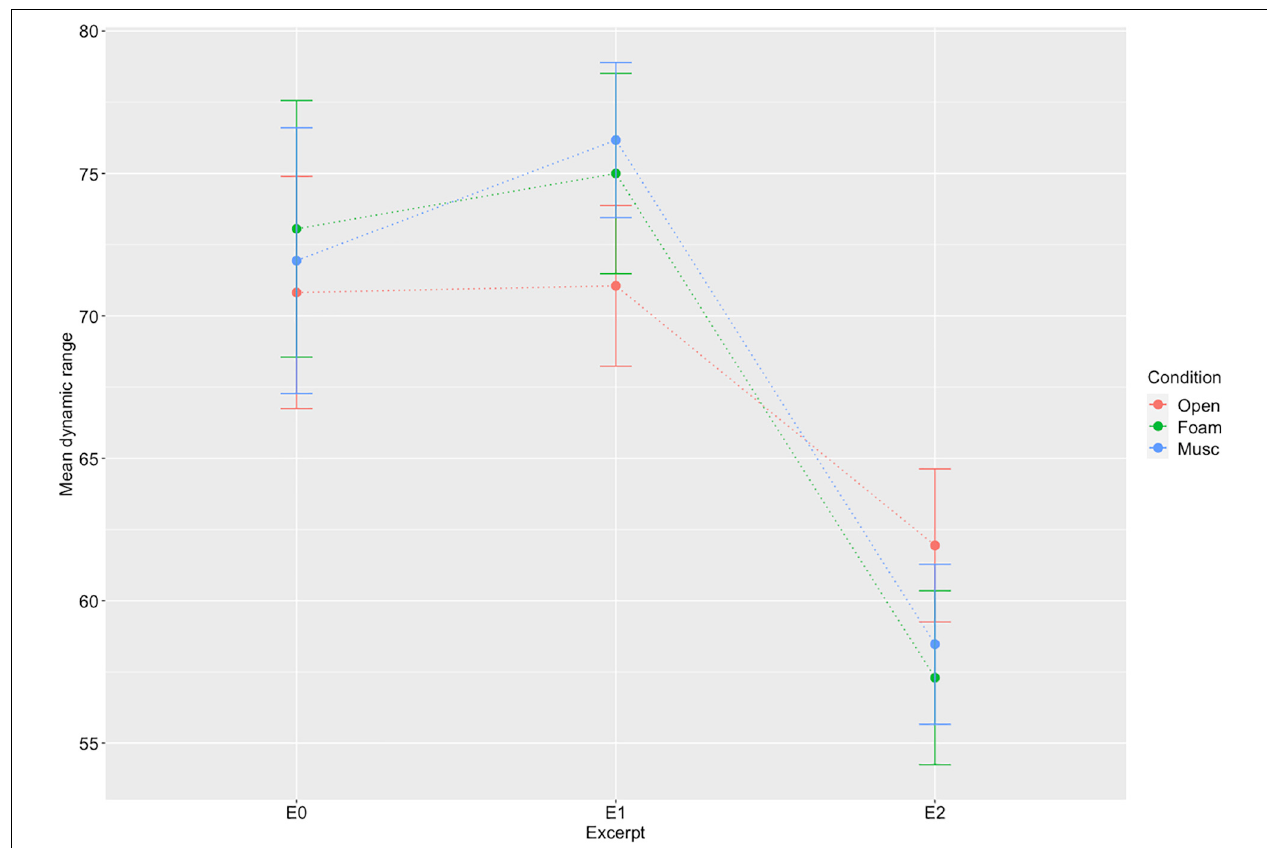
FIGURE 4 | Mean dynamic range (max-min velocity) and standard error by excerpt and hearing condition (Open, Musician earplugs, Foam earplugs) (all 17 participants). No effect of hearing condition was